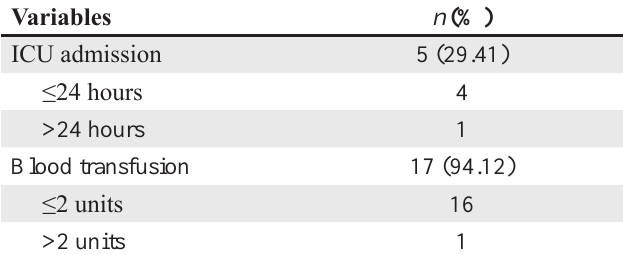
Table 2 : Post operative